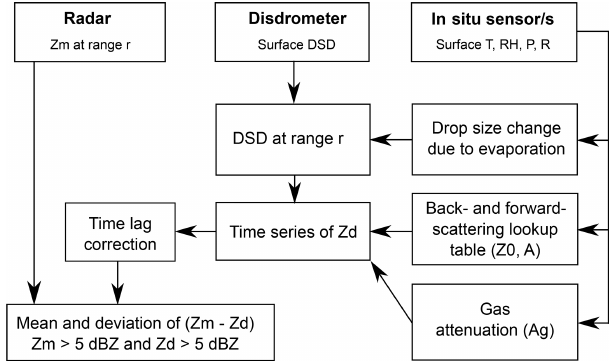
Figure 15. Schematic illustration of the extended disdrometer- based method. Detailed descriptions can be found in the